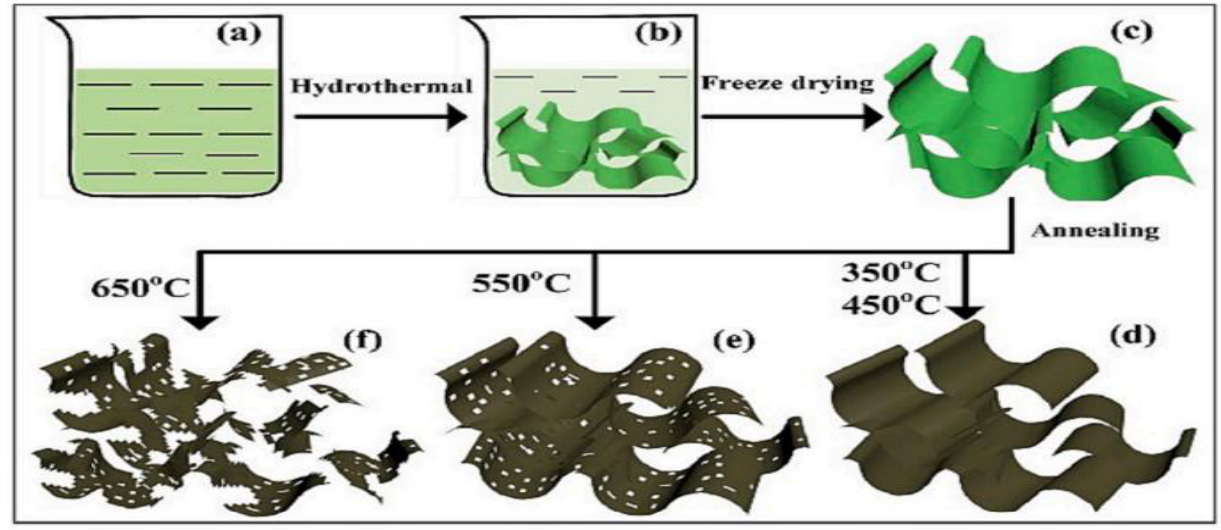
Figure 13. Synthesis flow diagram of NiO. Reprinted with permission from [134]. Copyright 2021